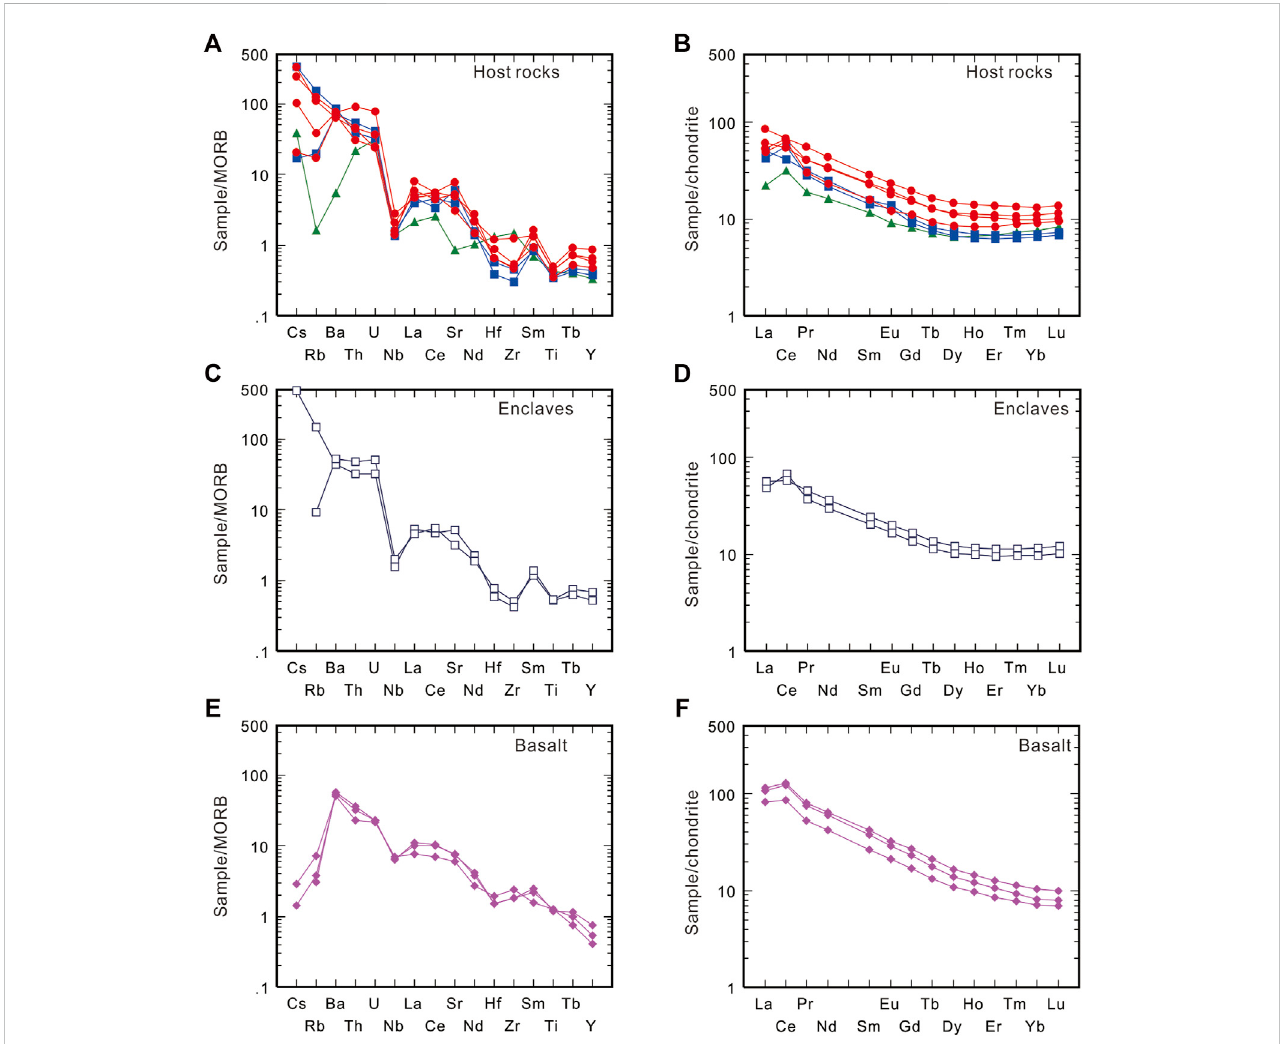
FIGURE 8 Mid-ocean ridge basalt (MORB) normalized incompatible element of the (A) host quartz dioritic and dioritic rocks, (C) the dioritic enclaves, and (E) the basalticrocks.ChondritenormalizedrareEarthelementdiagramsofthe (B) hostquartzdioriticanddioriticrocks, (D) thedioritichostrocks,and (F) thebasaltic rocks. Mid-ocean ridge basalt and chondrite normalizing values of Sun and McDonough (1989). Symbols of the Snoul pluton are the same as in Figure